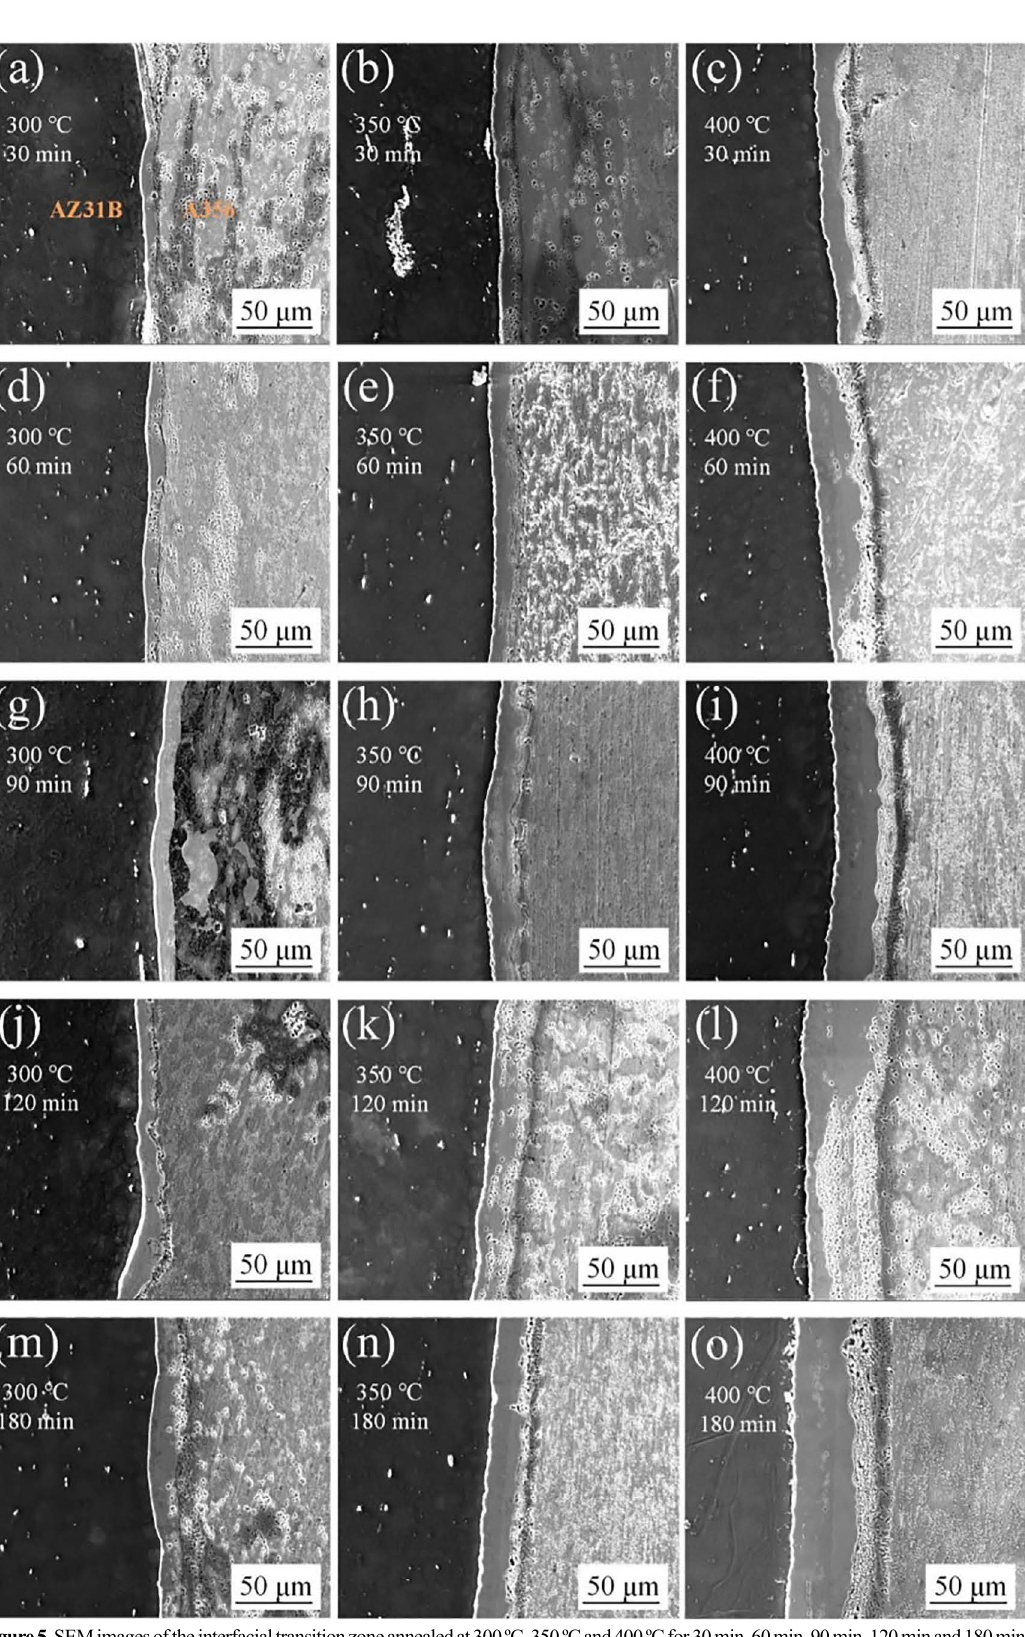
Figure 5. SEM images of the interfacial transition zone annealed at 300 ºC, 350 ºC and 400 ºC for 30 min, 60 min, 90 min, 120 min and 180